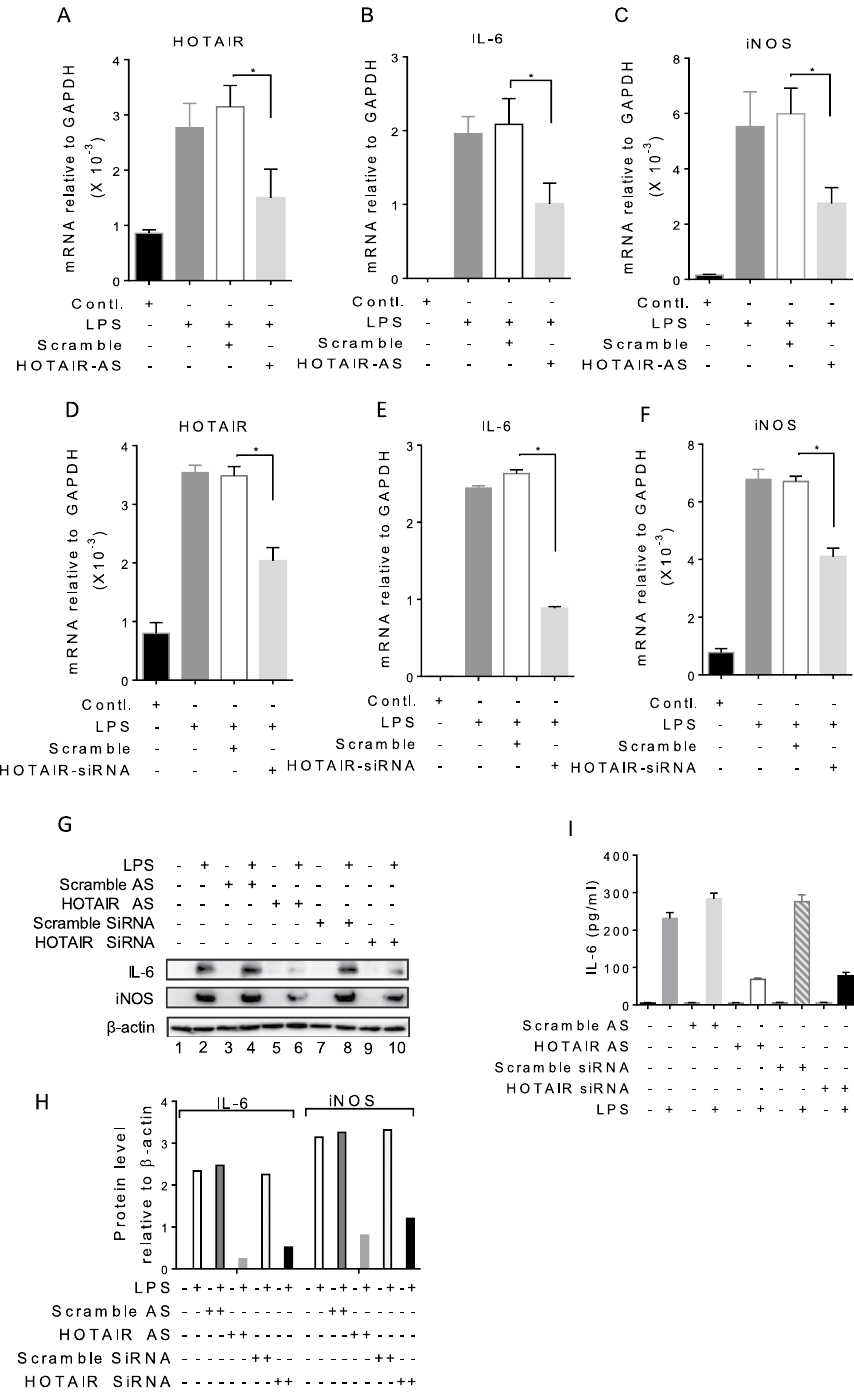
Figure 3. Knockdown of HOTAIR reduces LPS-induced IL-6 and iNOS expressions in macrophages. ( A – C ) Antisense-mediated knockdown of HOTAIR followed by treatment with LPS. RAW264.7 cells were transfected with HOTAIR-AS and scramble-AS, then treated with LPS for 4 h. RNA was analyzed by RT-qPCR for the expression of HOTAIR, IL-6, and iNOS. ( D – F ) siRNA-mediated knockdown of HOTAIR followed by treatment with LPS. RAW264.7 cells were transfected with HOTAIR-siRNA and scramble, RNA was analyzed RT-qPCR for the expression of HOTAIR, IL-6, and iNOS. GAPDH was used as control. Data represent mean ± SD (n = 3); * p < 0.05, ** p < 0.001, *** p < 0.0001. ( G , H ) Proteins from HOTAIR-antisense or HOTAIR-siRNA treatment followed by 6 h LPS-treated RAW264.7 cells were analyzed by Western blotting using antibodies against IL-6, iNOS and β -actin (loading control) ( G ). The changes in amounts of I κ B α and NF- κ B have been quantified by ImageLab5.2.1 software ( H ). ( I ) ELISA for IL-6 expression. HOTAIR was silenced in RAW264.7 macrophages by using HOTAIR-antisense and HOTAIR-siRNA separately, treated with LPS (12 h). Culture media were collected and amount of IL-6 secreted in culture media were measured using ELISA (n =